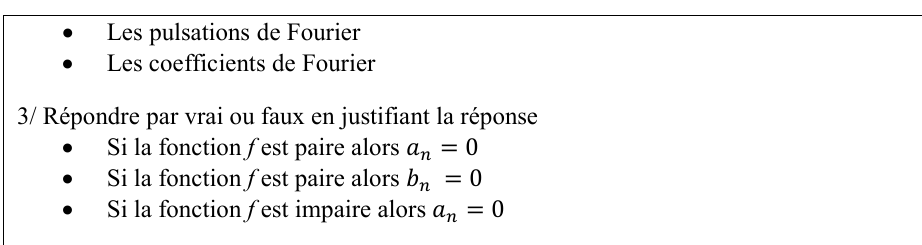
Tableau 1. Résultats de la partie 1 du questionnaire.